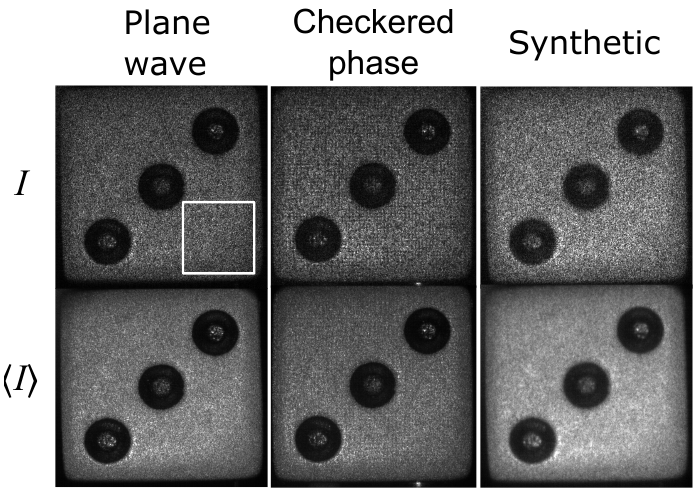
Figure 5. Results in reduction of speckle noise for the three methodologies. First row: single hologram reconstruction. Second row: Average of reconstructed